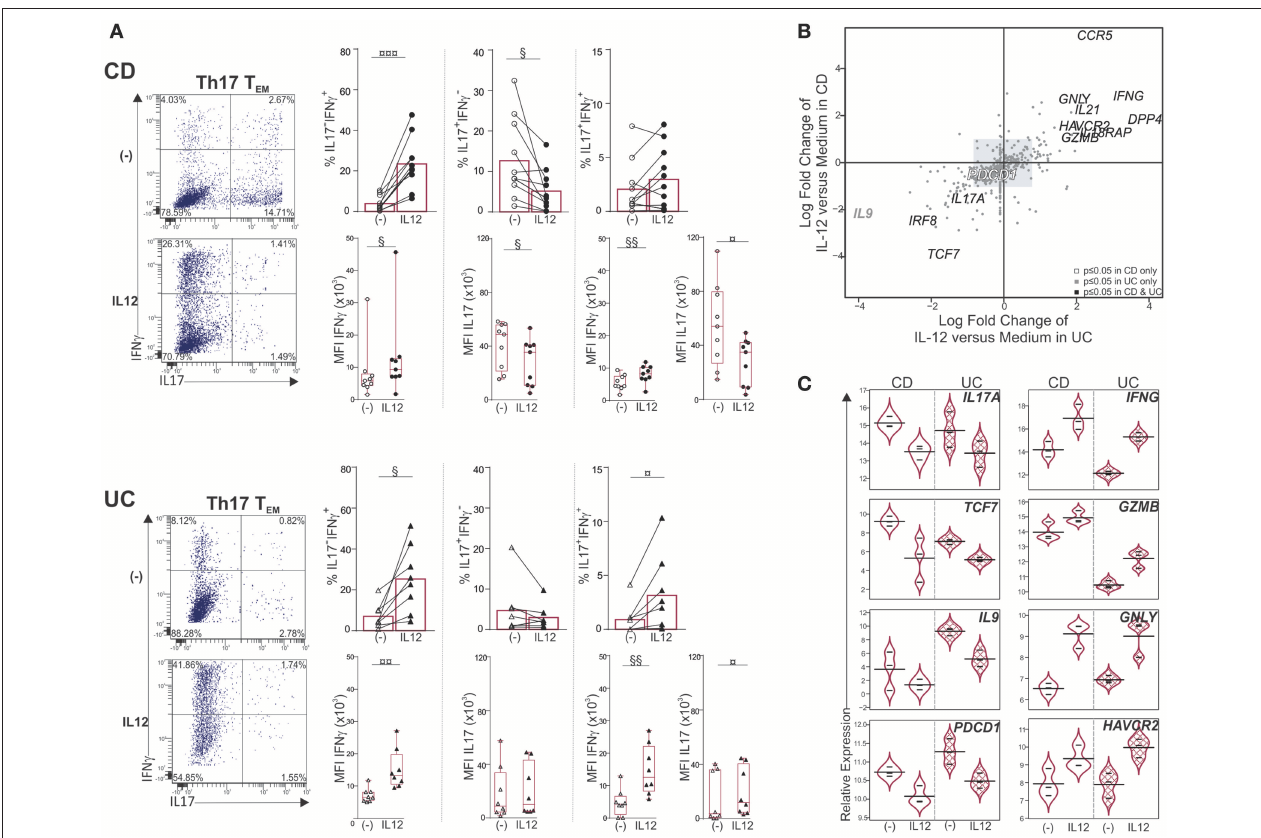
FIGURE 3 | IL12 shifts Th17 T EM cells toward Th1* in mLNs of CD and UC. Sorted mLN Th17 T EM cells were cultured with or without IL12 for 6 days. PMA-ionomycin was added for 6h and Brefeldin A for the last 3h. (A) Representative dot plots, frequencies and mean fluorescence intensity (MFI) of IL17 and IFN γ . (B,C) Molecular profiling of mLN Th17 T EM cells treated with medium or IL12 from CD ( n = 3) and UC ( n = 3) by Nanostring. (B) Quadrant analysis for differentially expressed genes in Th17 T EM , with IL12 treatment relative to medium, in CD vs. UC. (C) Violin plots illustrating relative expression of indicated genes. Paired t -test (§) or Wilcoxon signed rank test ( ¤ ). § , ¤ P < 0.05, §§ , ¤¤ P < 0.01, and ¤¤¤ P <